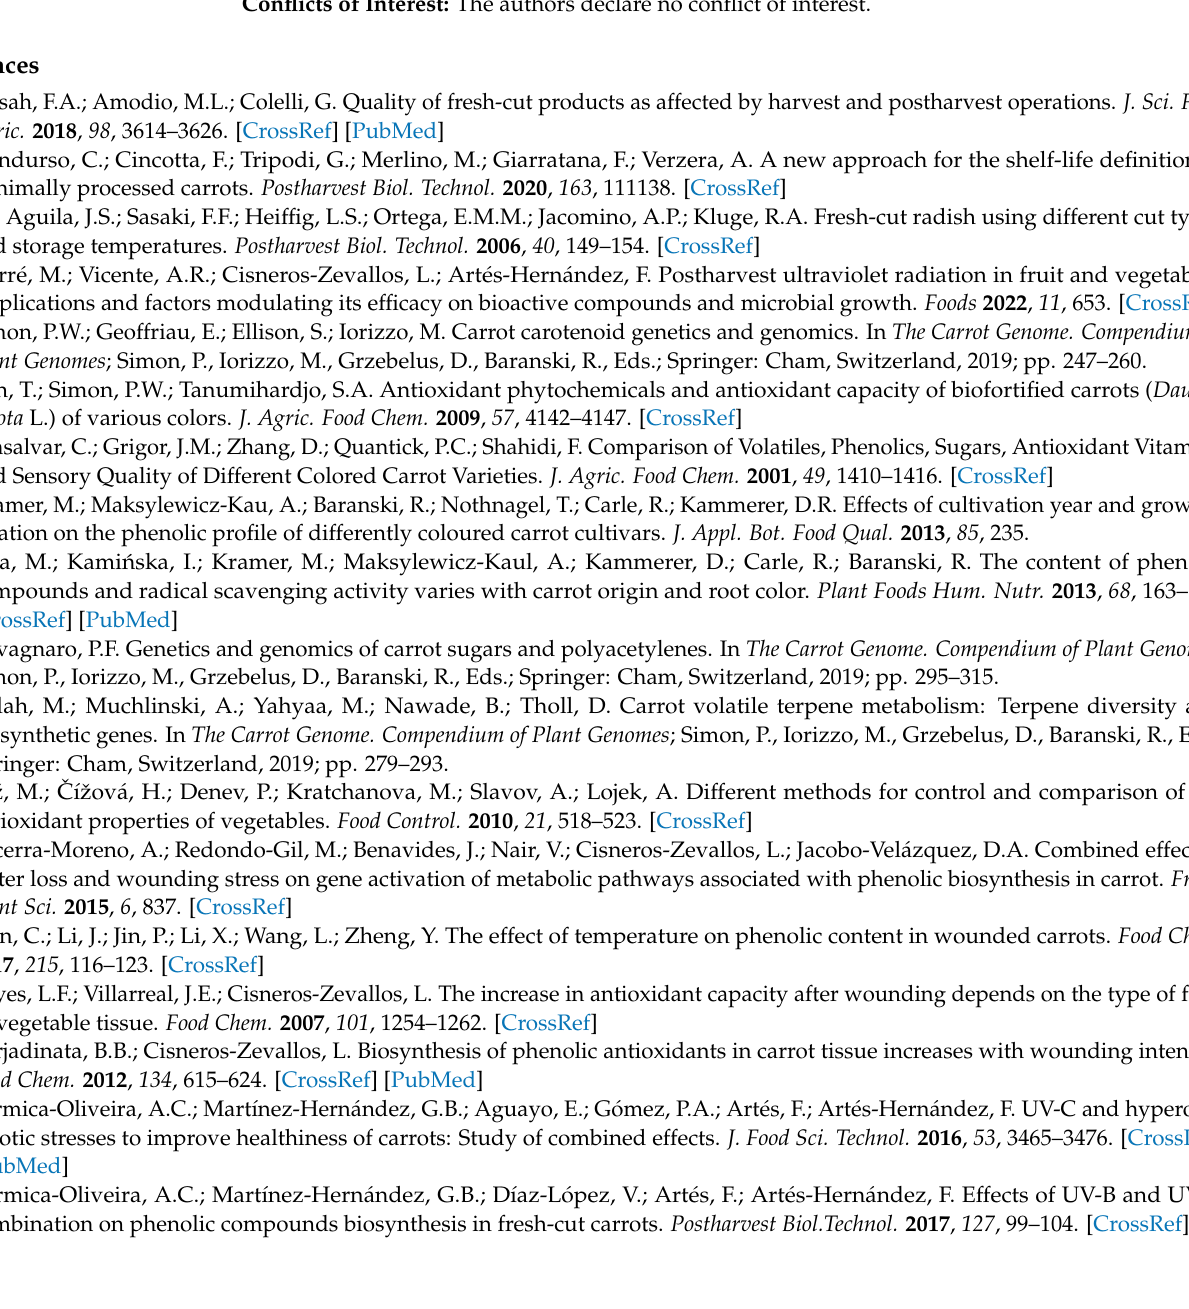
(black line) with adjusted trend line (black dashed line), and rainfall (green bars) at the cultivation site (Lujan de Cuyo, Mendoza, Argentina) for period from carrot sowing to harvest (15 October–15 March); Table S1: Root concentration of mayor anthocyanin glycosides in the purple-rooted cultivars Purplesnax and INTA44; Table S2: Edaphic characteristics of the carrot growing